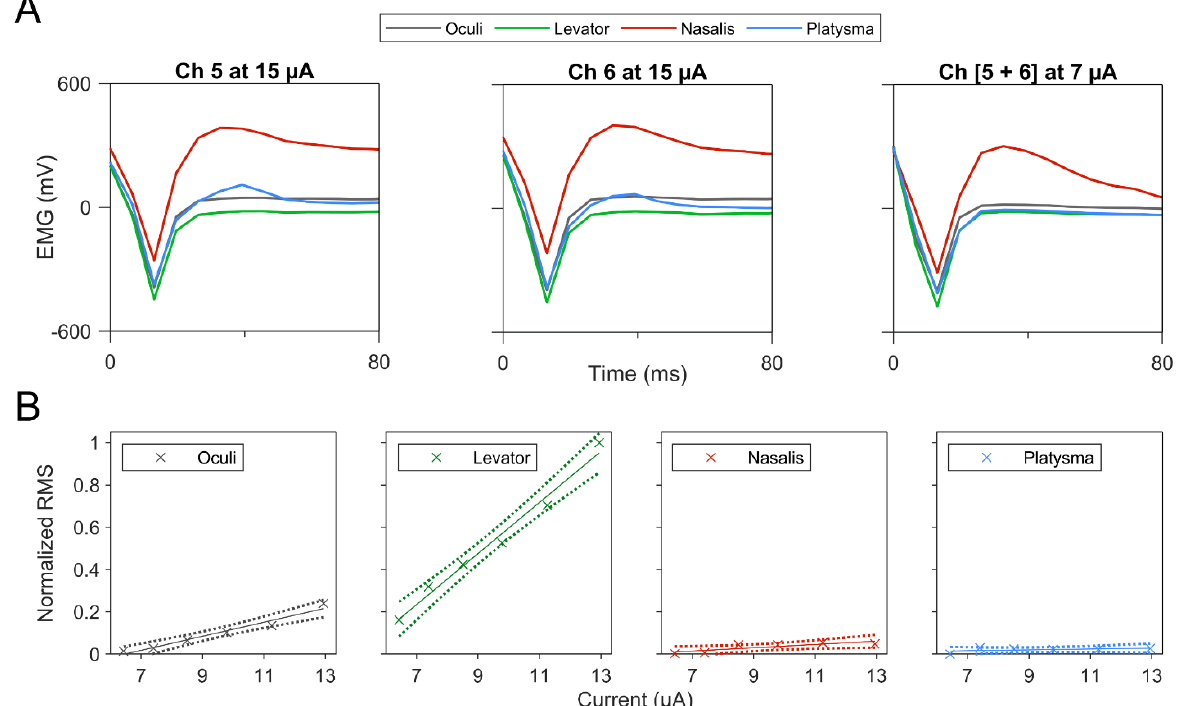
Figure 4. ( A ) Concurrent stimulation of channels 5 and 6 at a reduced current elicited similar activation of nasalis compared to independent stimulation of the channels. ( B ) Graded concurrent stimulation of channels 15 and 16 demonstrated a selective increase in EMG response for oculi and levator. Linear regressions (solid lines) and 95% confidence intervals (dotted lines) were derived from EMG measurements (“×” marks).